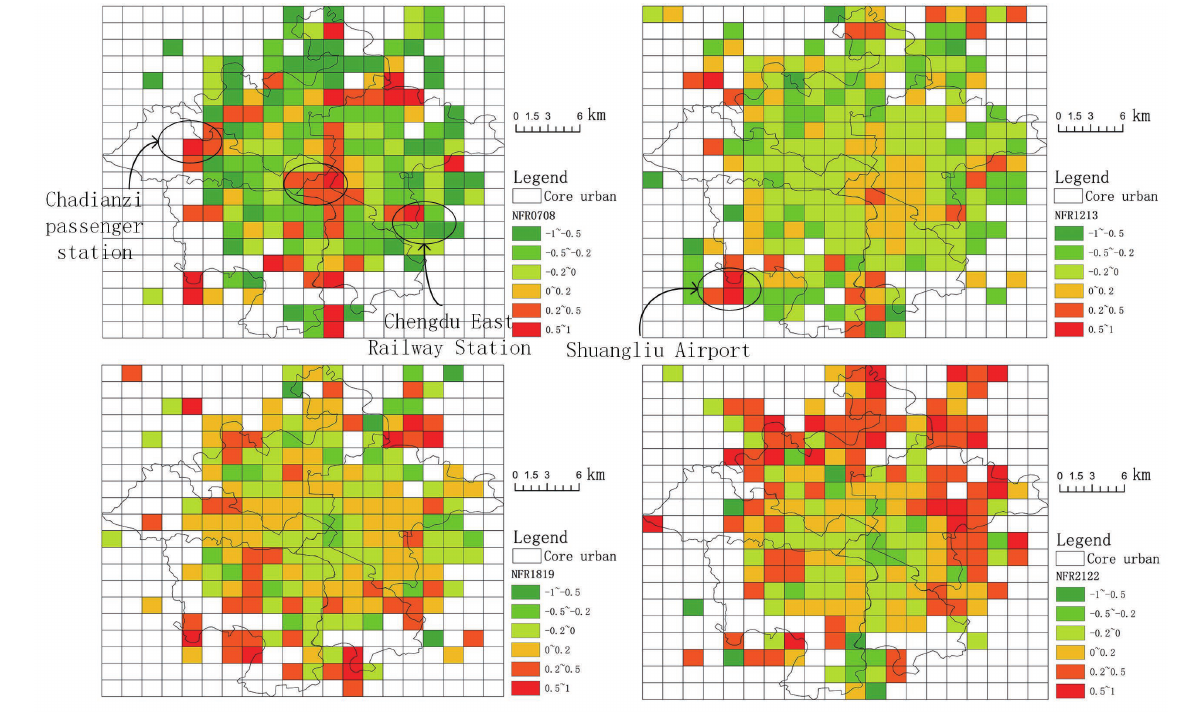
Figure 6. Distribution of spatial net flow ratio in four time periods. (The four time slots are 7:00–9:00 a.m., 12:00–2:00 p.m., 6:00–8:00 p.m., and 9:00–11:00